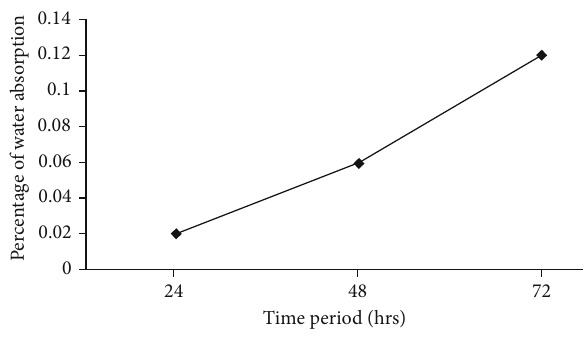
Figure 9: Water absorption of Al/GO samples.